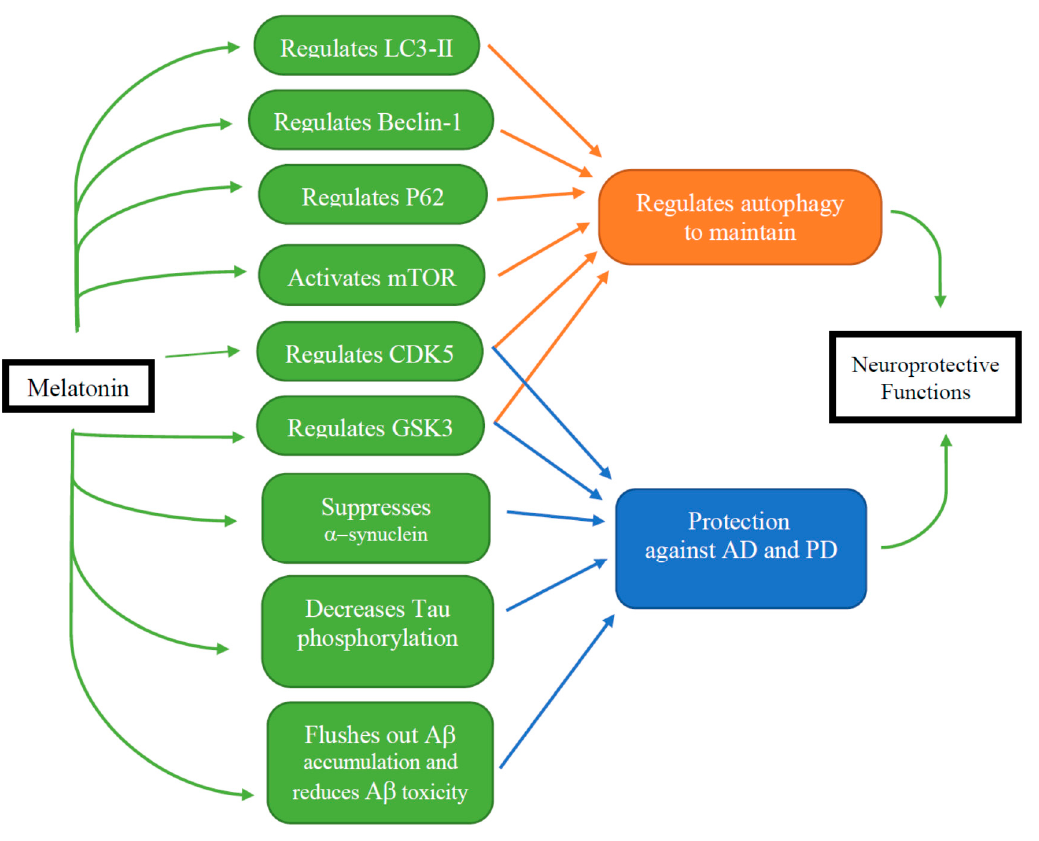
Figure 2. The multifaceted effects of melatonin. Melatonin regulates autophagy (via LC3-II, Beclin1, P62, and mTOR) as well as CDK5 and GDK3 to maintain cellular homeostasis. Neuroprotective mechanisms of melatonin include the decrease of tau phosphorylation, suppression of α -synuclein aggregation, flushing out of A β accumulation, and reduction A β toxicity in the experimental models of AD and PD.